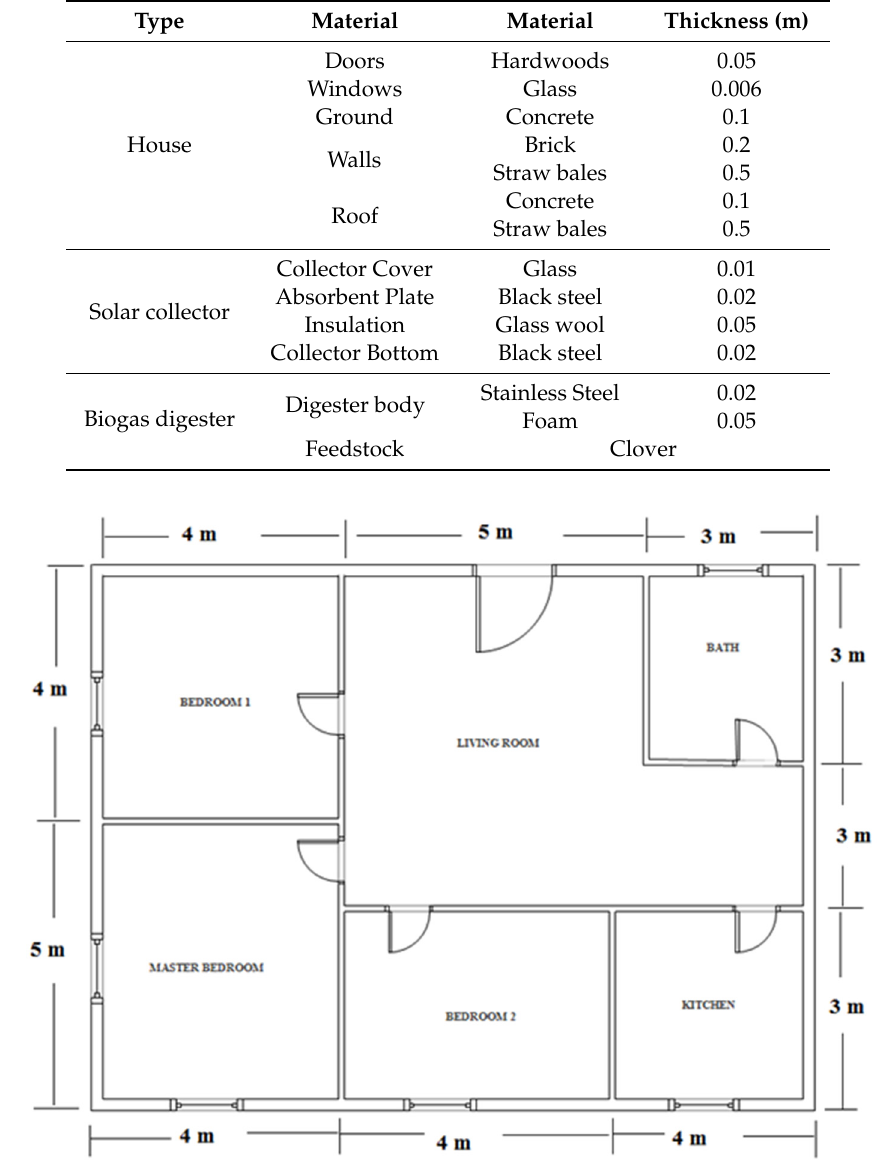
Table 2. Specifications of the bio-solar house.